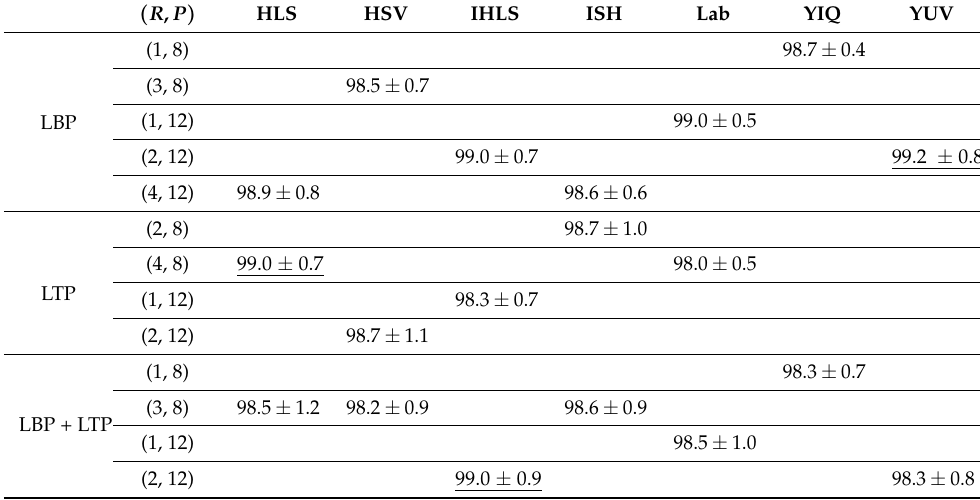
Table 1. The best results obtained for SWIMCAT dataset without using histogram selection method. Some of the best results for each color space, each feature, and the selected parameters ( R , P ) . ( R , P )